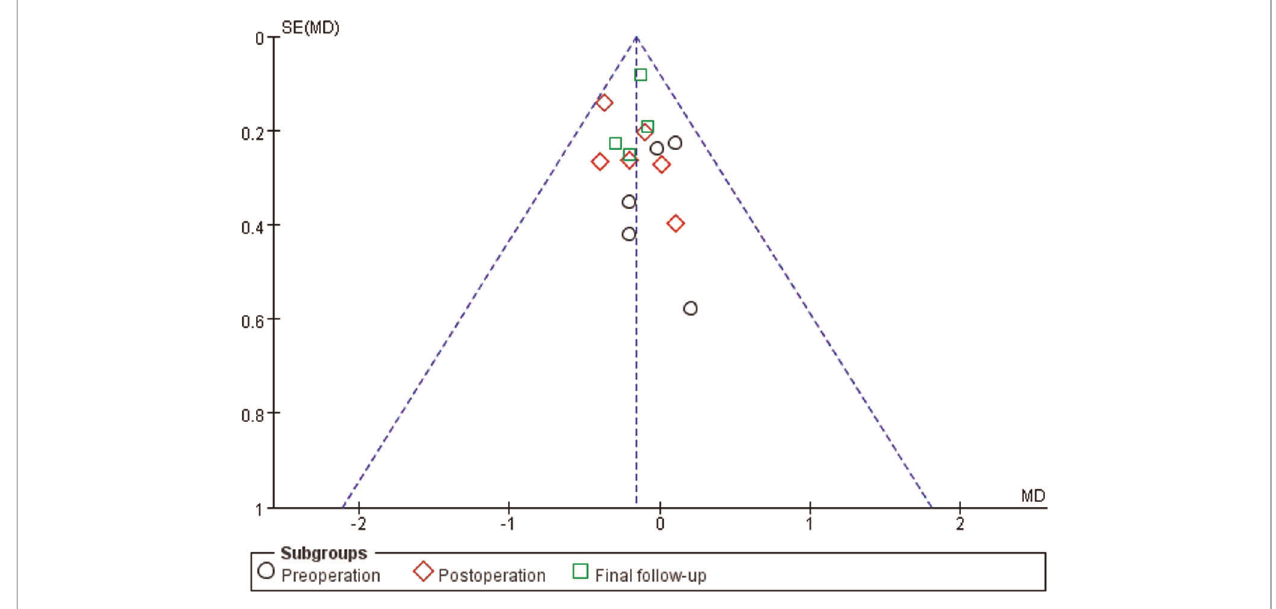
FIGURE 8 | Funnel plot of VAS scores for back pain.